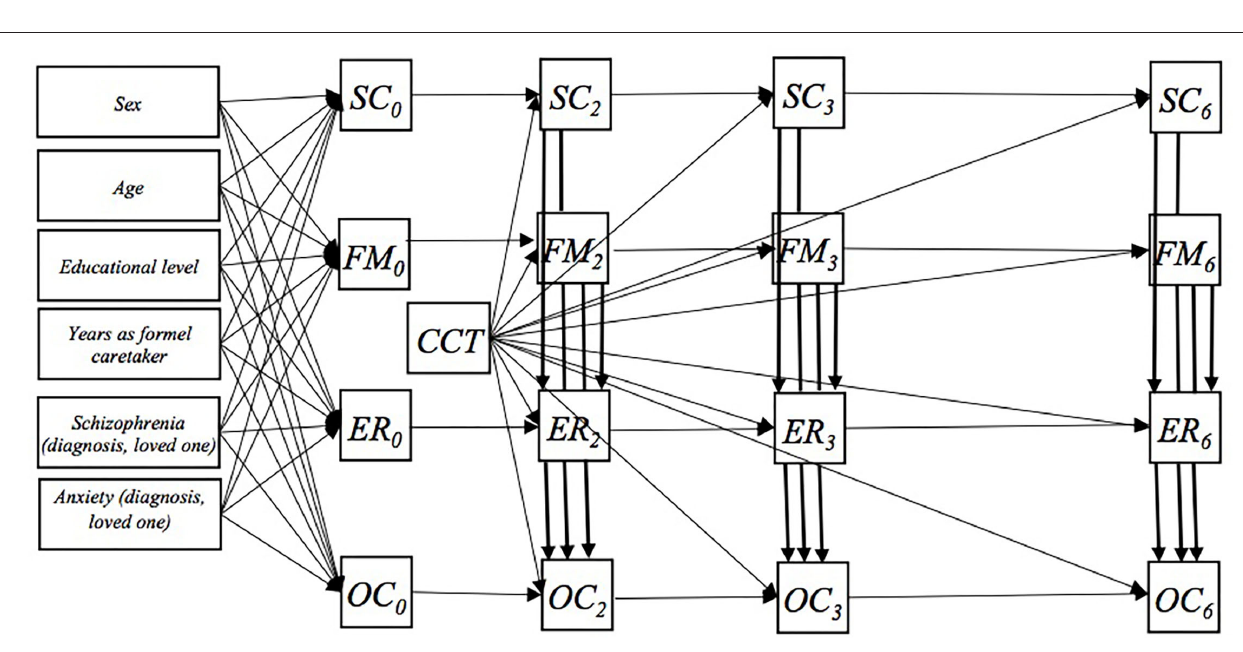
( Figure 2 ). The model with multiple mediators included direct paths from all mediators to the outcome (OC) and from FM and SC to ER. We fitted models in the structural equation model (SEM) framework in Stata 16 (28), using full information maximum likelihood and conditioning on covariates to account for missing data under the missing at random